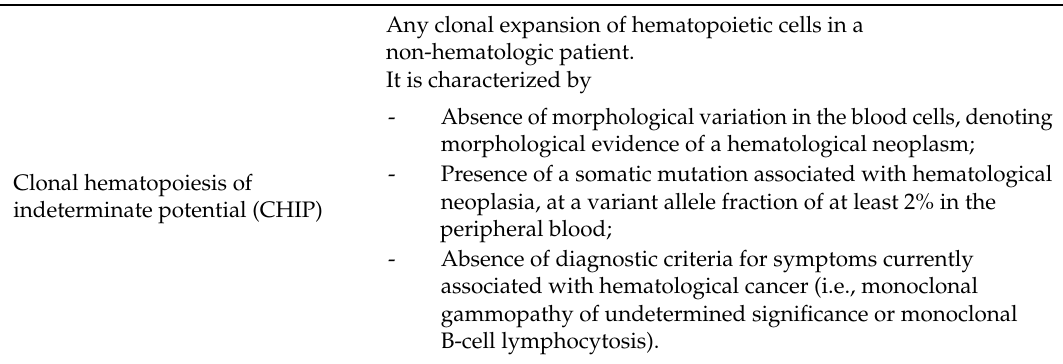
Table 2. Diagnostic criteria for clonal hematopoiesis of indeterminate potential (CHIP) [12,18].